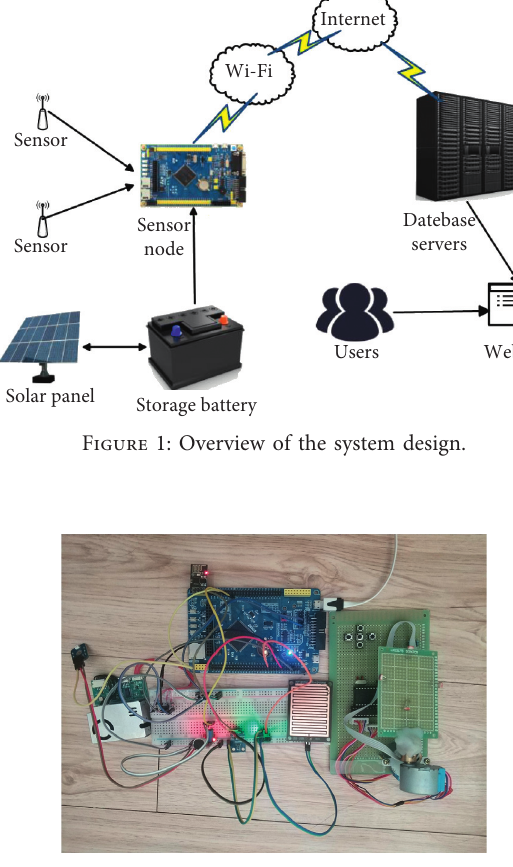
Figure 2: Hardware connection of the Table 1: Detail parameters of each sensor.